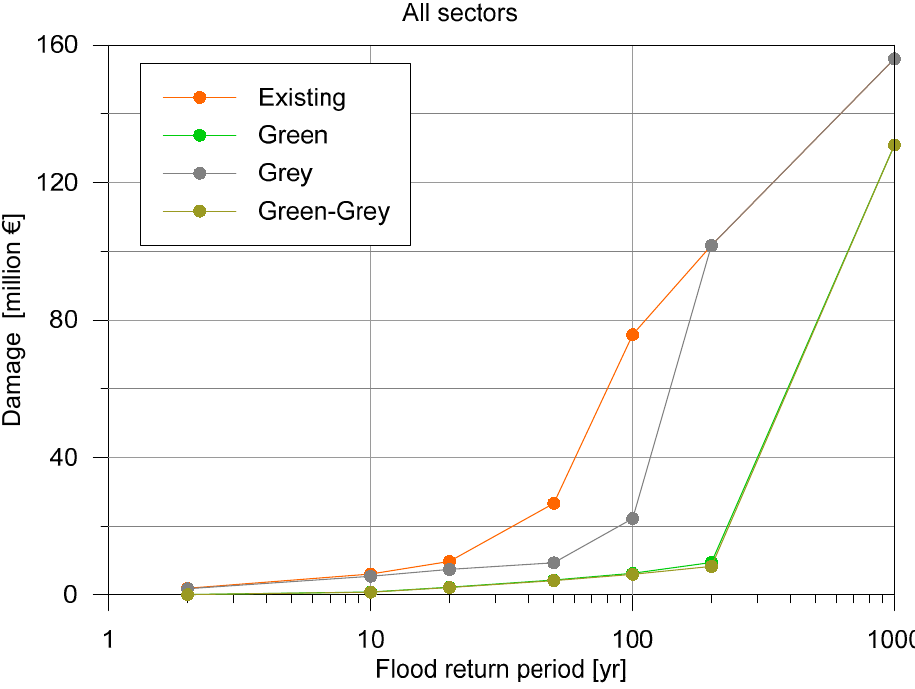
Figure 9. Total flood damages due to flood events of various return periods under the four flood mitigation scenarios in the Tamnava watershed.